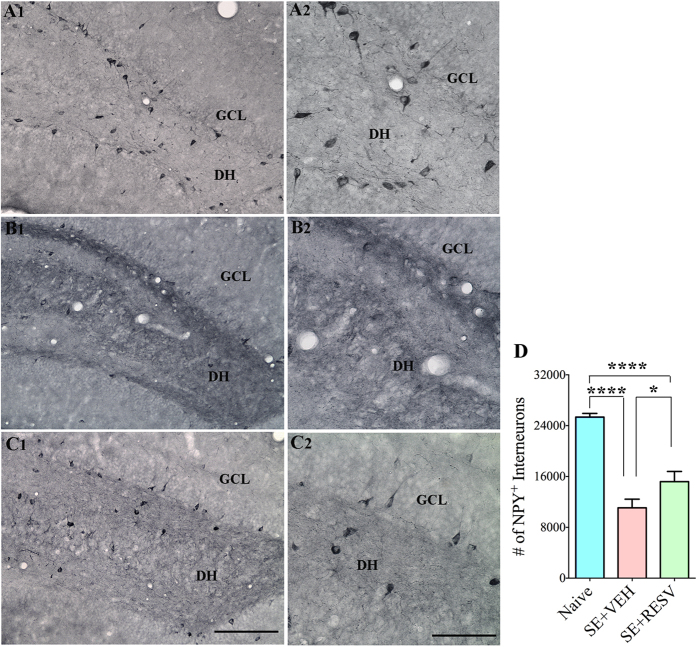
Resveratrol (RESV) treatment after status epilepticus (SE) moderated the loss of interneurons expressing neuropeptide Y (NPY) in the dentate gyrus (DG).Figures A1, B1 and C1 show the distribution of NPY + interneurons in the DG from a naïve control rat (A1) and rats that received vehicle (VEH; B1) or RESV (C1) after SE. Figures A2, B2 and C2 are magnified views of regions from A1, B1 and C1. DH, Dentate hilus; GCL, granule cell layer. Scale bar: (A1,B1,C1) 200 μm; (A2,B2,C2) 100 μm. Bar chart compares the numbers of interneurons positive for NPY in the DG between naïve control rats and rats that received VEH or RESV after SE. Note that, in comparison to naïve control rats, rats receiving VEH after SE display a major reduction in numbers of NPY + interneurons. In contrast, rats receiving RESV during and after SE display reduced loss of NPY + interneurons and hence show greater numbers surviving NPY + interneurons than rats receiving VEH after SE. DH, Dentate hilus; GCL, granule cell layer. *p < 0.05; ****p < 0.0001.